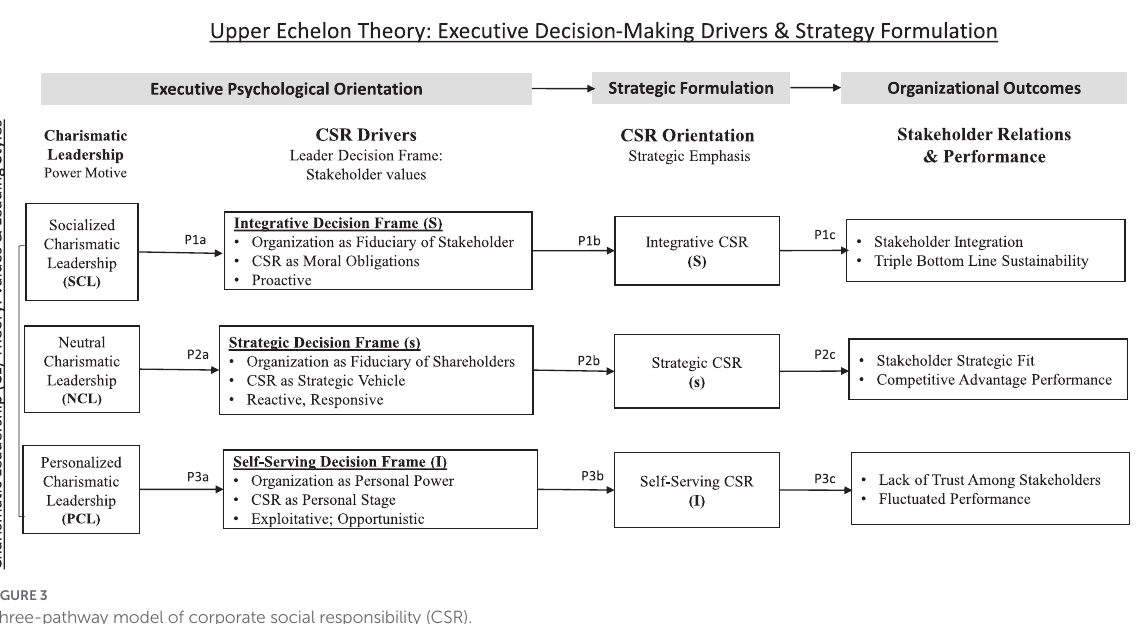
FIGURE 3 Three-pathway model of corporate social responsibility